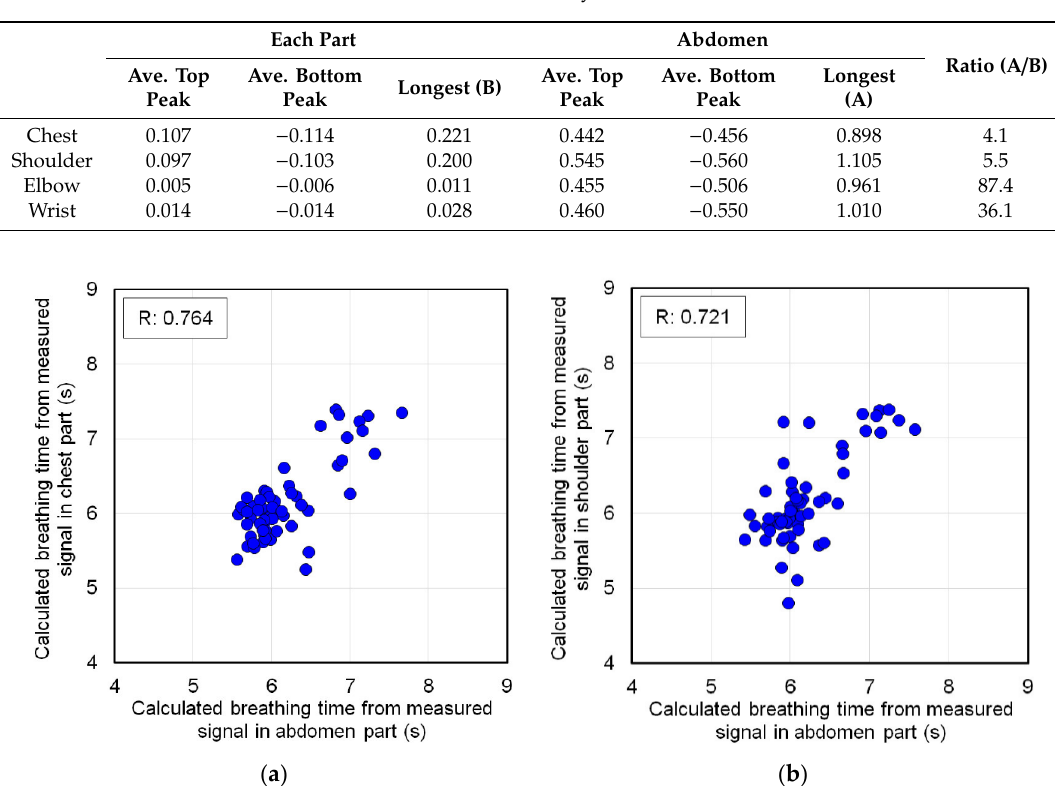
Table 4. Top peak, bottom peak, and the longest amplitude of the measurement signals at the chest, shoulders, elbows, and wrists, measured simultaneously with the abdomen.